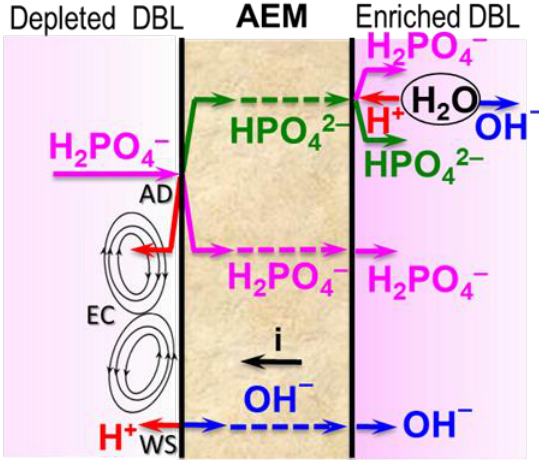
Figure 5. Scheme of phenomena affecting phosphate transfer in ED desalination of NaH 2 PO 4 solution. Explanations are in the text.